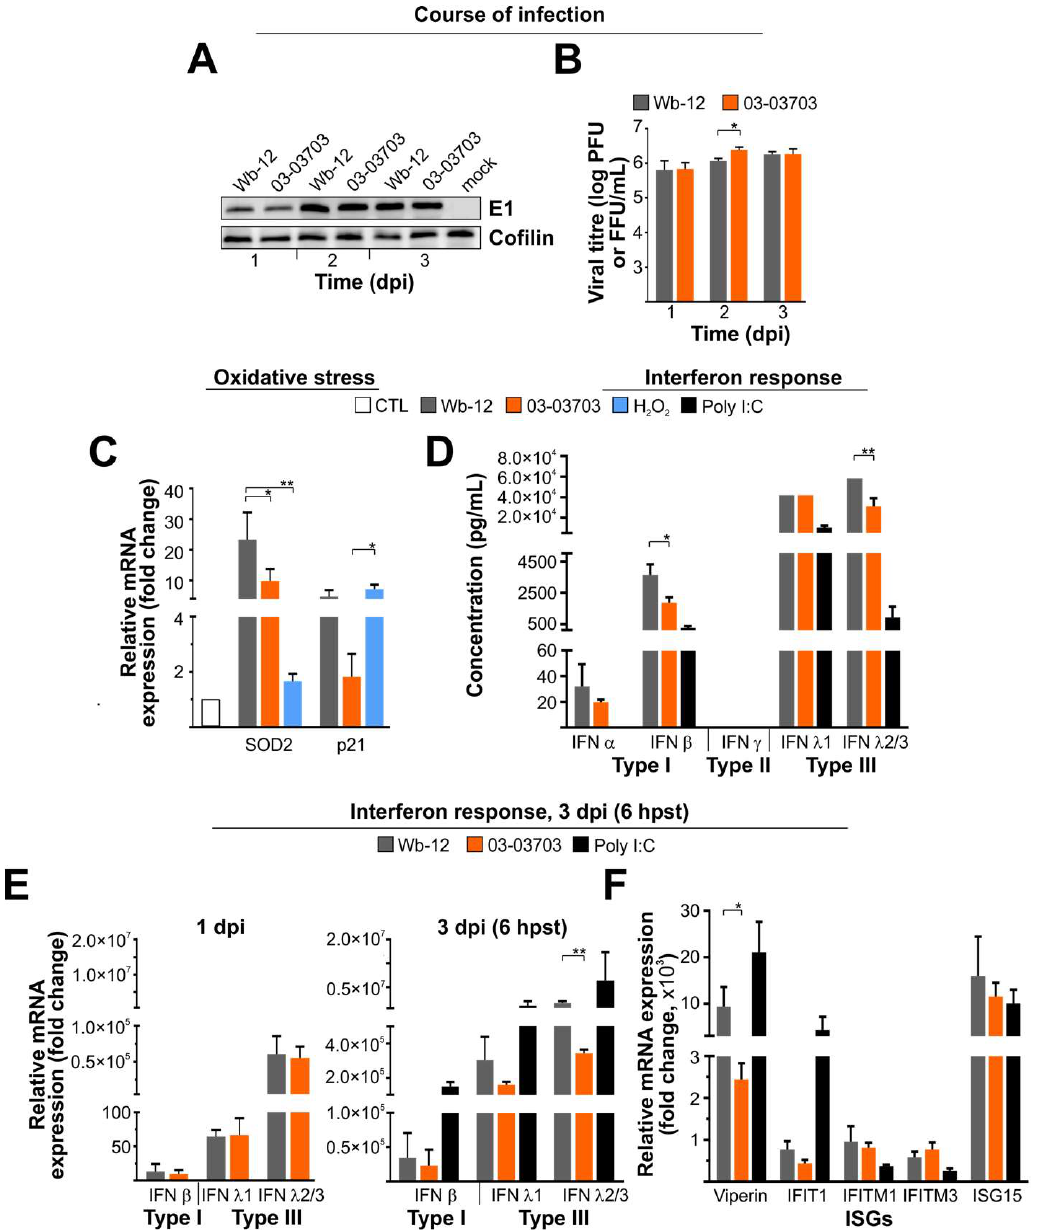
Figure 4. In contrast to the induction of oxidative stress, the RV-associated interferon (IFN) response on A549 cells was comparable among RV strains. ( A ) Western blot analysis of mock- and RV-infected A549 cells was performed at indicated time points with an antibody against RV E1 protein. The image shown is representative for three Western blot runs with independent samples; ( B ) Virus progeny generation was assessed by plaque (Wb-12) and focus forming assay (03-03703); ( C ) At 3 dpi the expression level of the antioxidant enzyme SOD2 and the oxidative stress-sensitive protein p21 was determined at mRNA expression level by qRT-PCR. H 2 O 2 applied over night at a 1:5000 dilution was used as positive control; ( D ) The LEGENDplex IFN panel was used to obtain the IFN profile for Wb-12- and 03-03703-infected A549 cells at 3 dpi. The lack of error bars is due to the upper detection limit of the assay, which was present despite analysis of a 1:4 dilution of the supernatants collected from mock- and RV-infected A549 cells; ( E ) The type I and III IFNs mRNA expression level was determined by qRT-PCR for samples extracted from Wb-12- and 03-03703-infected A549 cells at 1 and 3 dpi; ( F ) Activation of IFN-stimulated genes (ISGs) was validated by qRT-PCR for Wb-12- and 03-03703-infected A549 cells (obtained at 3 dpi); ( E , F ) Expression level was normalized to hypoxanthine guanine phosphoribosyl transferase (HPRT1) and expression is given relative to the corresponding mock- or untreated control (CTL); ( D – F ) As a positive control, RNA extracted at 6 h post-transfection (hpst) from polyinosinic-polycytidylic acid (poly I:C)-transfected A549 cells was used. As a negative control mock-infected and lipofectamine2000-transfected samples were employed for RV infection and poly I:C transfection, respectively. *, p < 0.05; **, p < 0.01.